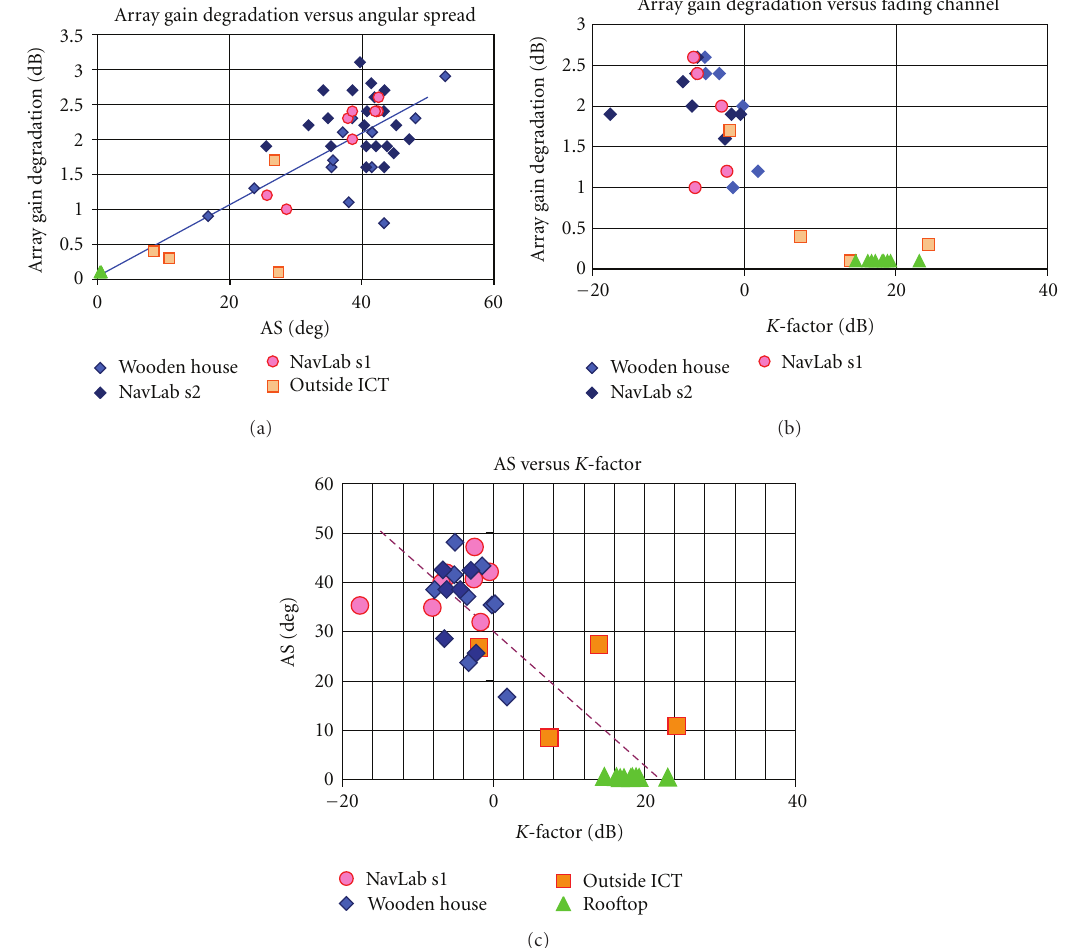
Figure 13: (a) Array gain degradation versus angular spread. (b) Array gain degradation versus K -factor. (c) Angular spread versus K -factor.